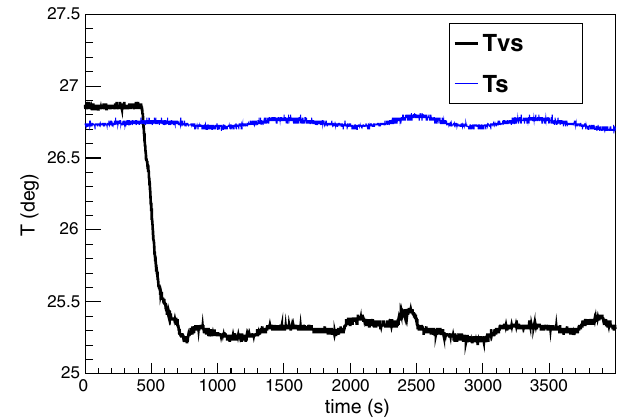
FIG. 5. Stability of water-temperature-control unit. T vs is the temperature of the water provided to the vane channel, and T s is that of the water supplied to this unit. At t ¼ 430 s , T vs was changed from 26.9 to 25 : 3 (cid:1) C , and after about 300 s, T vs became stable within (cid:3) 0 : 13 (cid:1) C .